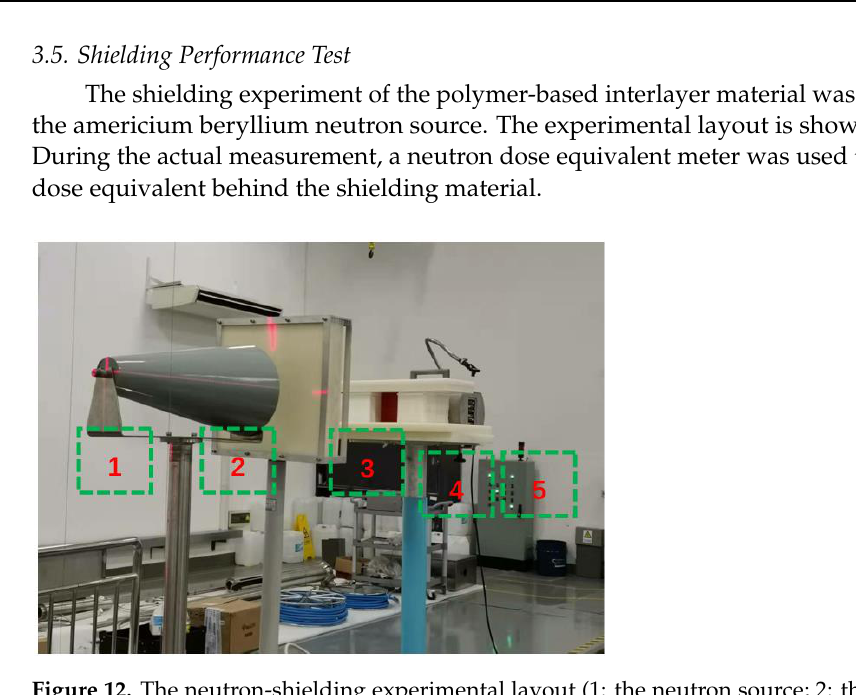
Figure 12. The neutron-shielding experimental layout (1: the neutron source; 2: the shadow cone; 3: the polyethylene moderator layer; 4: the polyethylene shield layer (to shield incident neutron); and 5: the neutron dose equivalent meter).